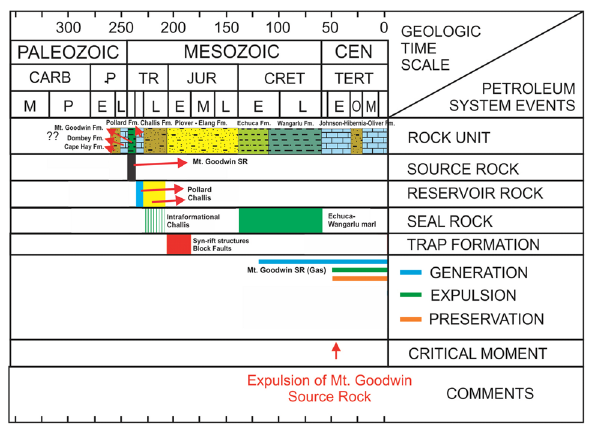
Fig. 6 Local petroleum event chart for offshore western Timor.